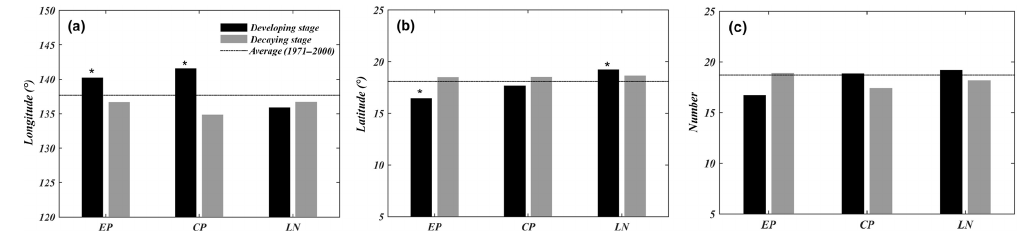
Figure 8. Anomalies in TC genesis longitude (a) , latitude (b) , and number (c) during JASO over the WNP. The dashed line indicates the average value for 1971–2000. The asterisk indicates 95% significance.